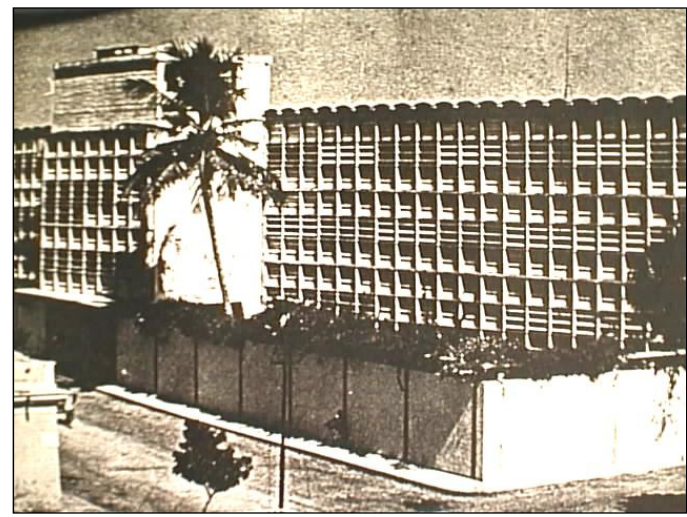
Figure 6. Ashram of Sri Aurobindo. Pondicherry, India.